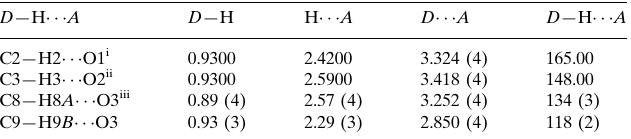
software used to prepare material for publication: WinGX (Farrugia, 1999) and PLATON